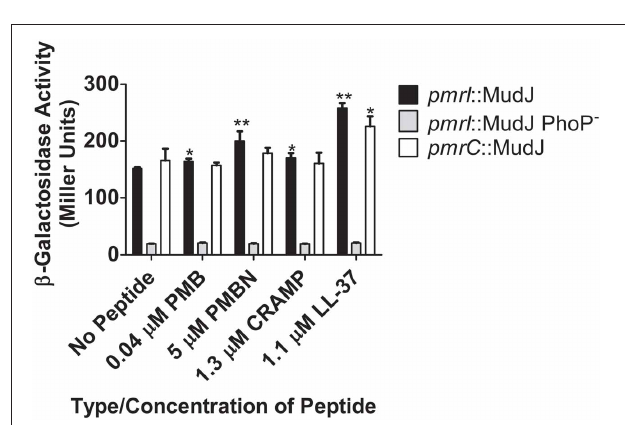
FIGURE 2 | TCRS-mediated activation of S . Typhimurium pmrI and pmrC in response to CAMPs. β -galactosidase assays demonstrate that different CAMPs induce varying levels of PmrA-regulated gene promoter expression and CAMP sensing by PhoQ. Subsequent PmrA-mediated β -galactosidase reporter gene activation is abolished in the absence of PhoP. Values shown represent the mean ± standard deviation from a representative experiment performed at least twice in triplicate. Statistical significance was measured against the samples to which no peptide was added. ∗ Indicates p < 0 . 05; ∗∗ indicates p < 0 .